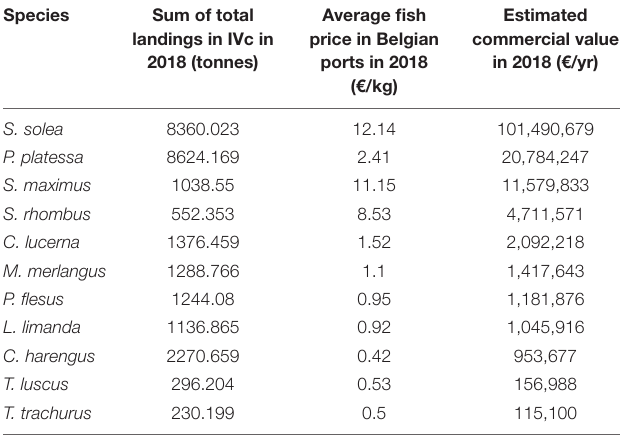
TABLE 5 | The commercial value (€/yr) for selected fish species, in 2018, based on the sum of the total landings in ICES area IVc (i.e., the Southern North Sea at Belgium, the Netherlands, and Southern United Kingdom) from the ICES Catch Statistics and the average fish price in Belgian ports.